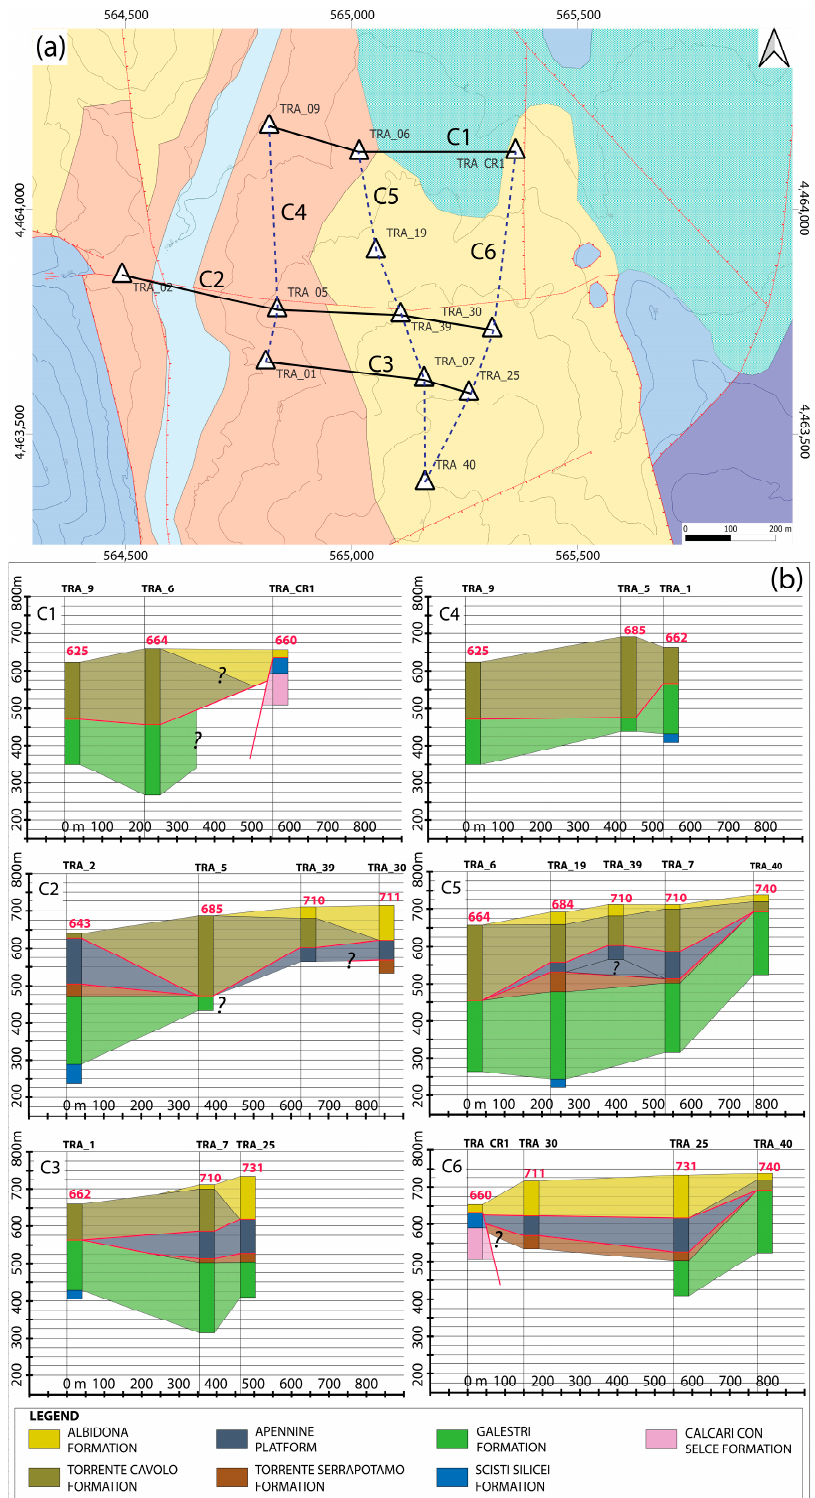
Figure 7. ( a ) Locations of some wells drilled in the study area. The wells present in the map were used for stratigraphic correlations ( b ). The C1, 2 and 3 correlation traces have been drawn with black lines in the E–W direction, while the C4, 5 and 6 traces are draw with dotted blue traces and are oriented in the N–S